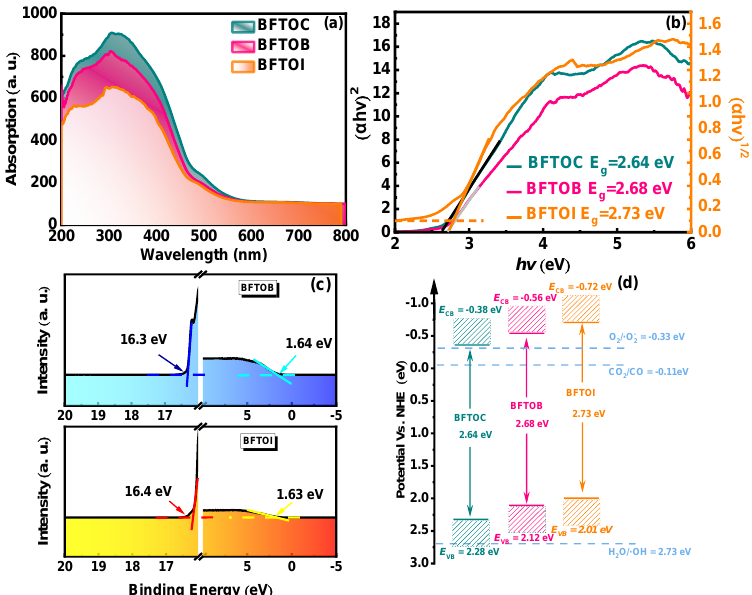
Figure 5. ( a ) UV-vis diffuse reflectance spectrum ( DRS ) of BFTOX (X = Cl, Br, and I) samples. ( b ) The calculated E g of BFTO-X from Tauc’s band-gap plots. ( c ) UPS valence band spectra of BFTOBr and BFTOI; ( d ) The energy band structure of BFTOX (X = Cl, Br, and I).